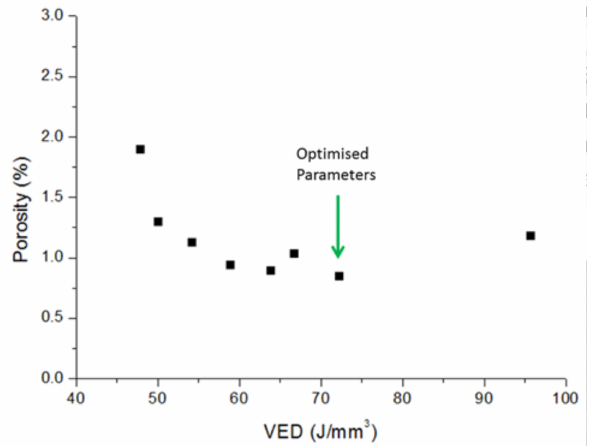
Figure 3. Porosity versus Volumetric Energy Density (VED) graph of 50% 7075 Laser Powder Bed Fusion (LPBF)